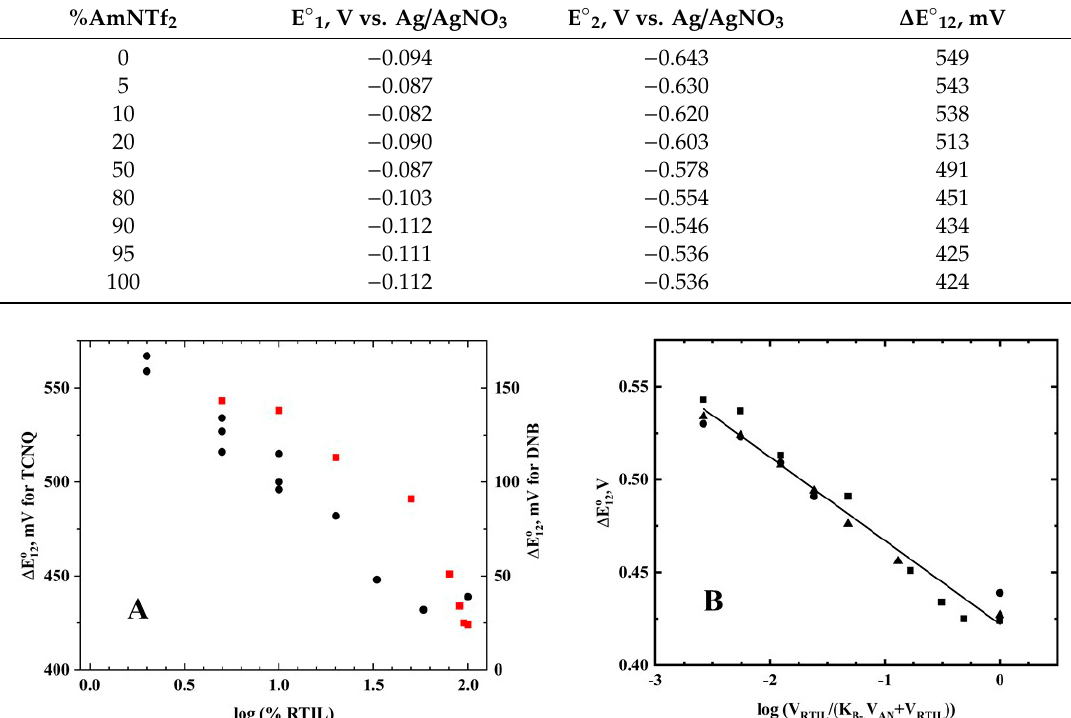
Table 2. Cyclic voltammetry at 100 mV / s for TCNQ in acetonitrile / AmNTf 2 .